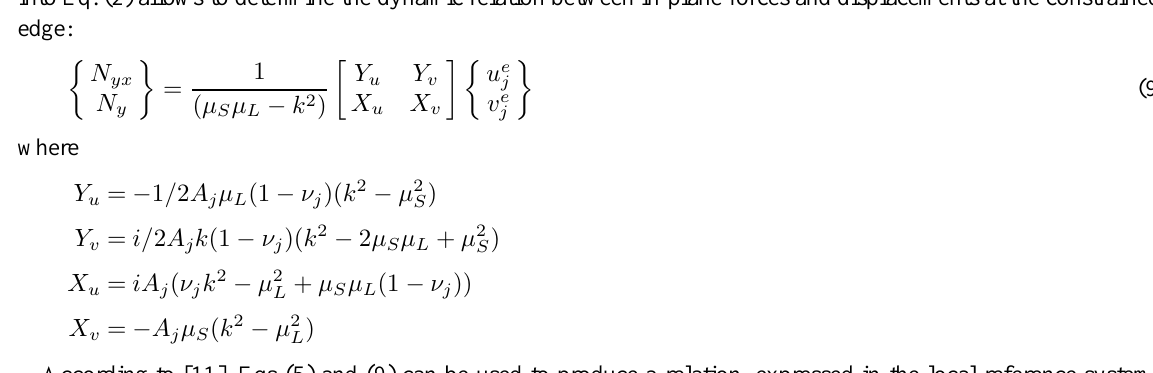
Fig. 6. Comparison between accelerations predicted by MSC-NASTRAN (continuous line) and by wave propagation analysis (dashed line) at node 226. variables u and v are expressed as a function of the constraint edge degrees of freedom; this last equation